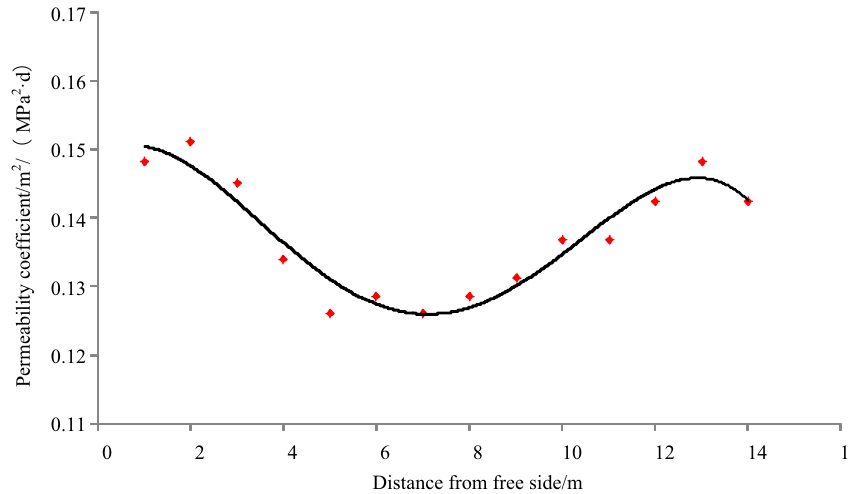
Figure 4. Distribution of permeability in different stress zones after coal excavation.